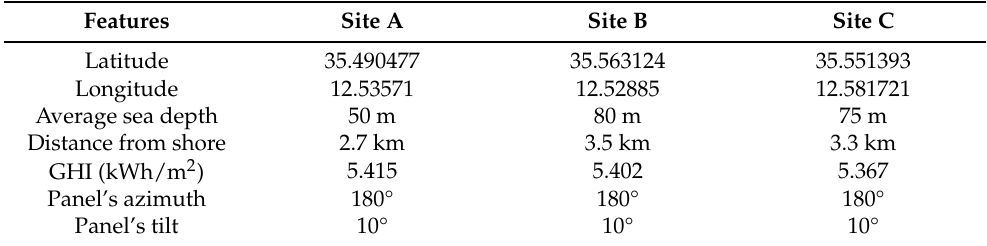
Table 1. Characteristics of selected